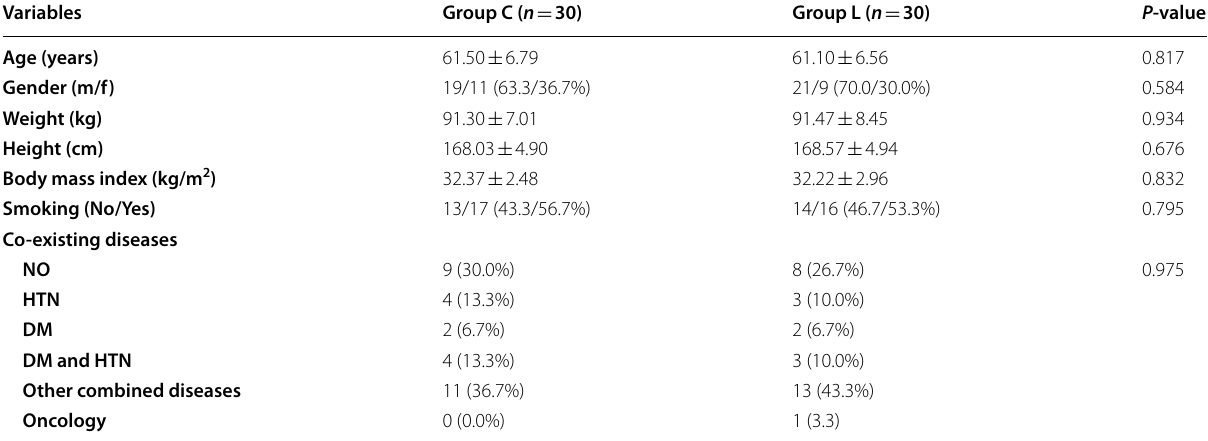
Data are presented as mean